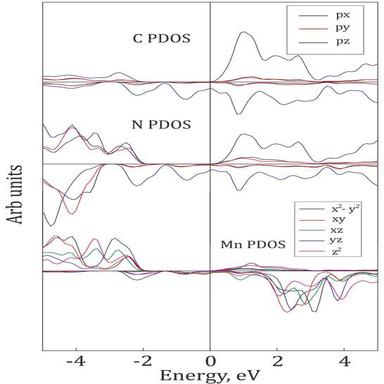
Orbital resolved PDOSes of (Mn)@(g-CN1)2 calculated at GGA/HSE level of theory.